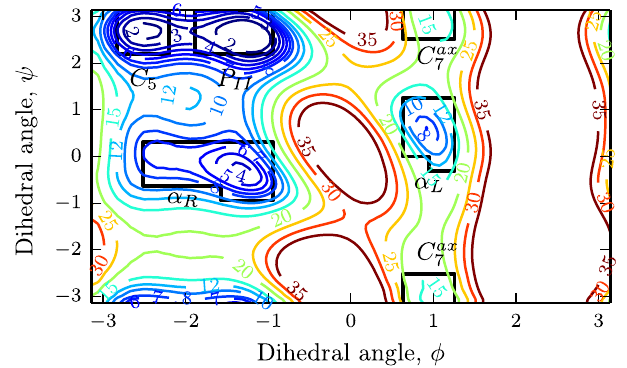
FIG. 5. Free-energy profile of alanine dipeptide as a function of the dihedral angles. Energies are given in kJ = mol. The average thermal energy k B T at 300 K is 2 . 493 kJ = mol. One can identify five metastable sets on the dihedral angle torus, indicated here by black lines. There are three low-energy (high-probability) sets C 5 , P , and α R , with ϕ < 0 , and two high-energy (low-probability) II sets α R and C ax 7 , with ϕ > 0 .